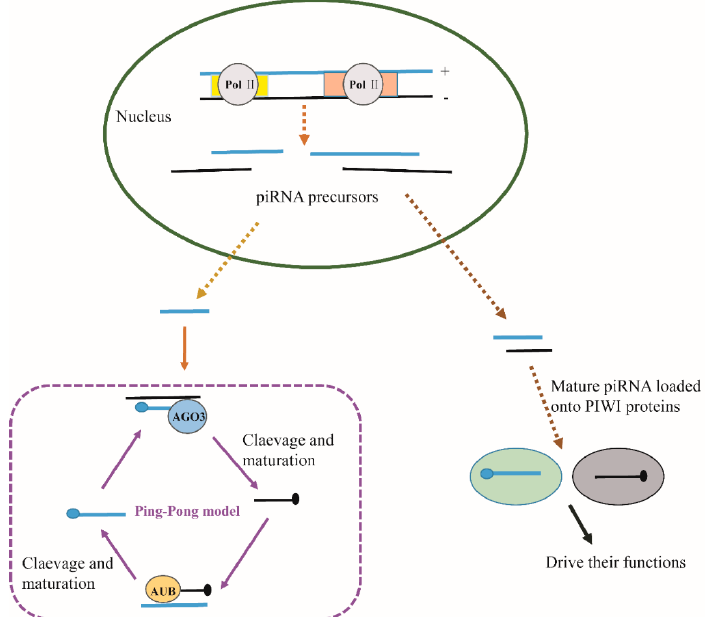
Figure 3. Biogenesis of piRNAs and the “Ping-Pong” model in D. melenogaster . piRNA clusters in the genome can be transcribed in either direction, sense or antisense. The long single-stranded RNA is